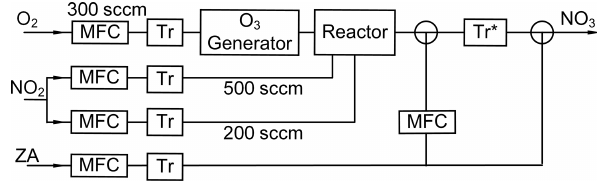
Figure 5. Schematic diagram of NO 3 generation system with flow paths (arrows). Dry-ice cold traps for H 2 O removal (Tr) and for sample collection (Tr ∗ ) are also